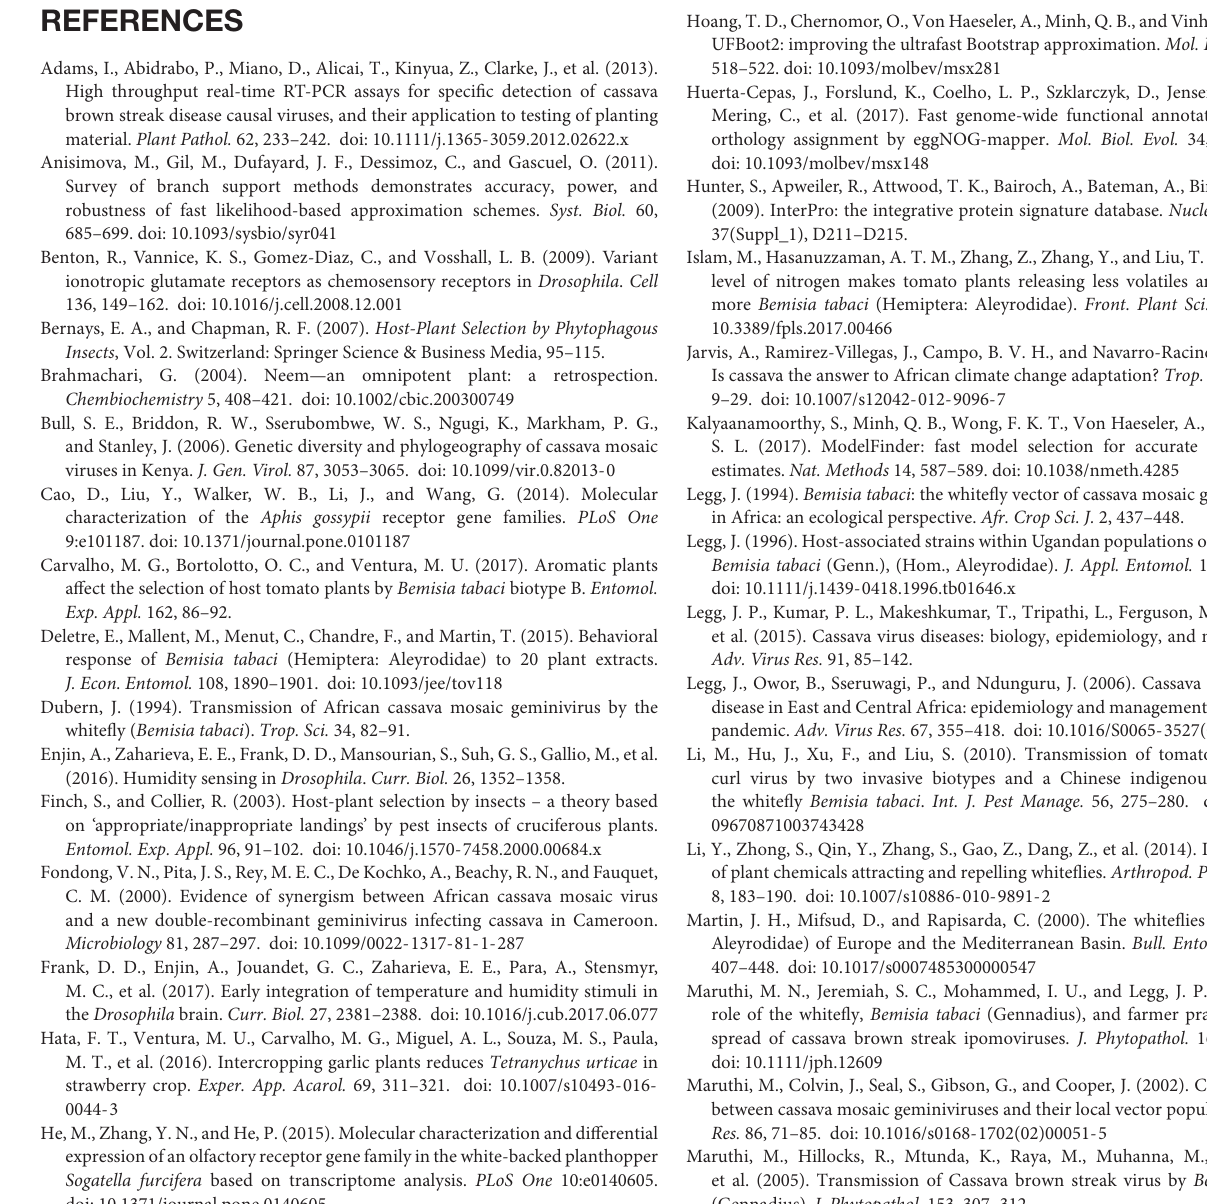
the present study.